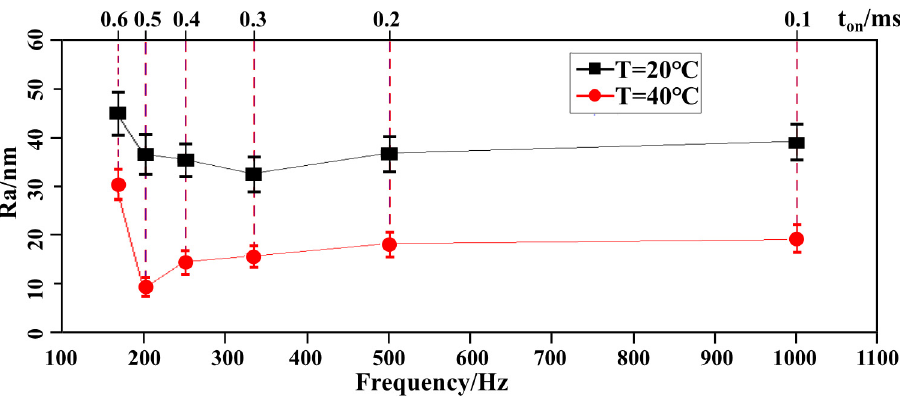
Figure 5. The relationship between 𝑅𝑎 and the frequency of pulse electroplating at 20 °C and 40